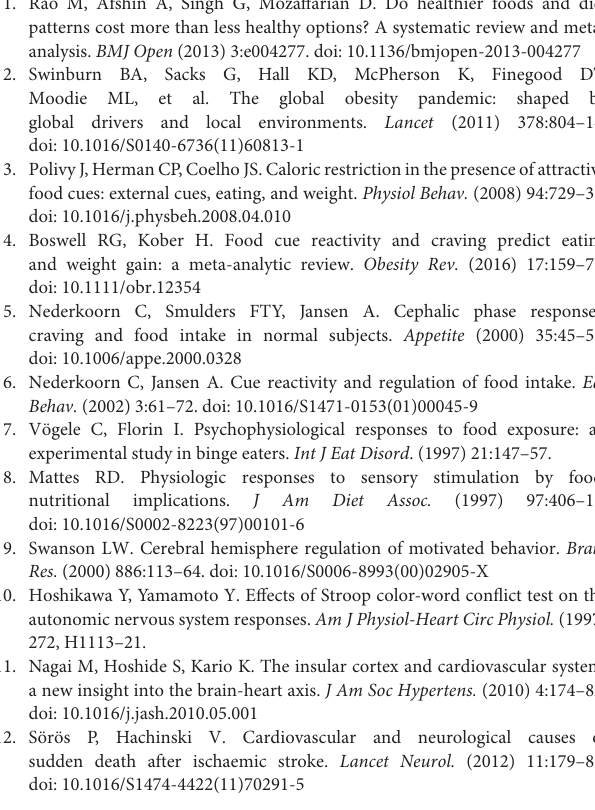
Frontiers in Nutrition |